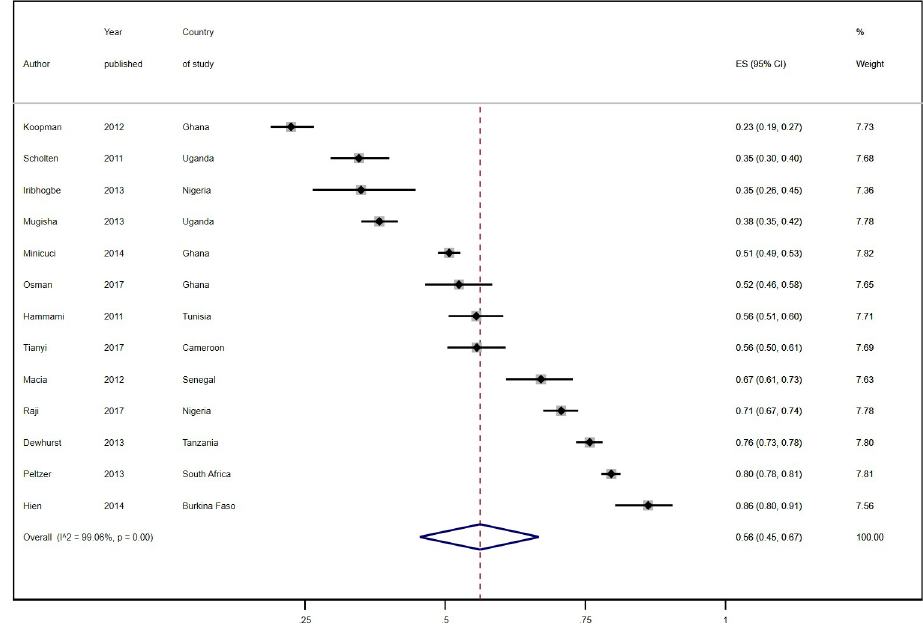
Fig 5. Prevalence estimates of hypertension in female